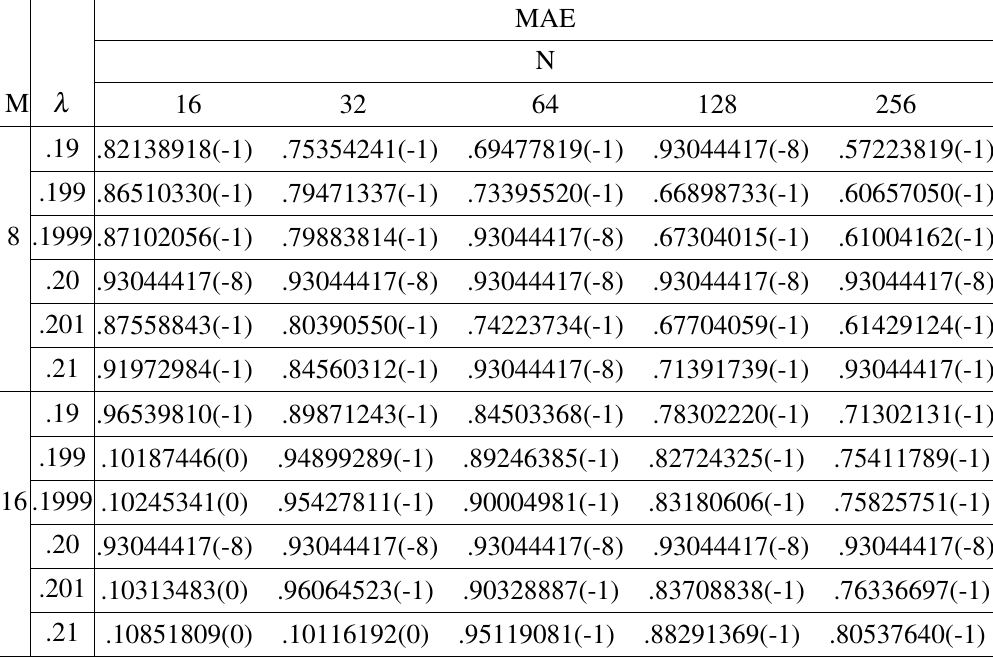
Table 1 Maximum absolute error (Problem